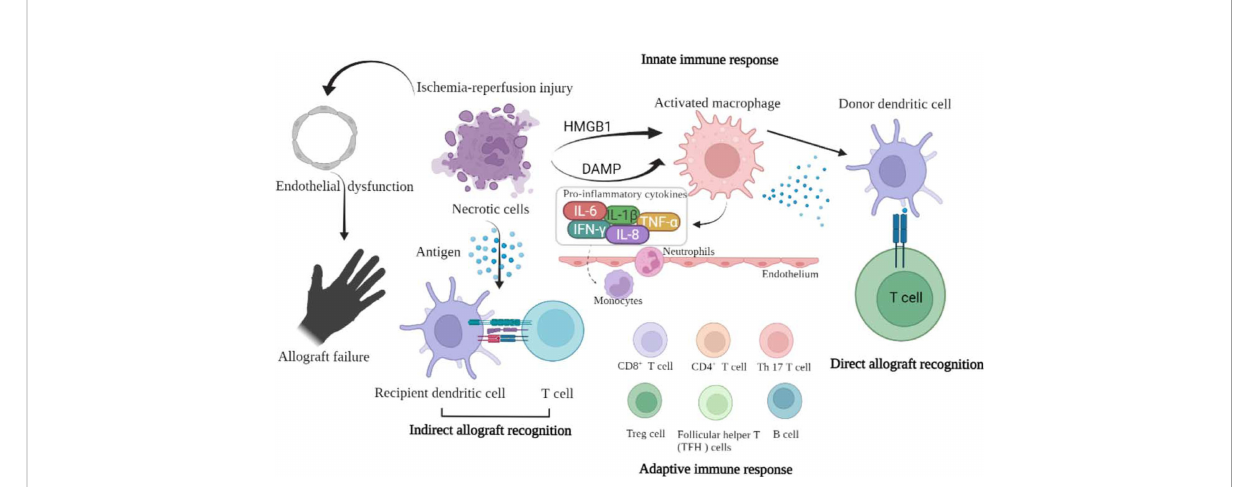
FIGURE 1 The schematic picture shows the relationship between ischemia-reperfusion injury and graft